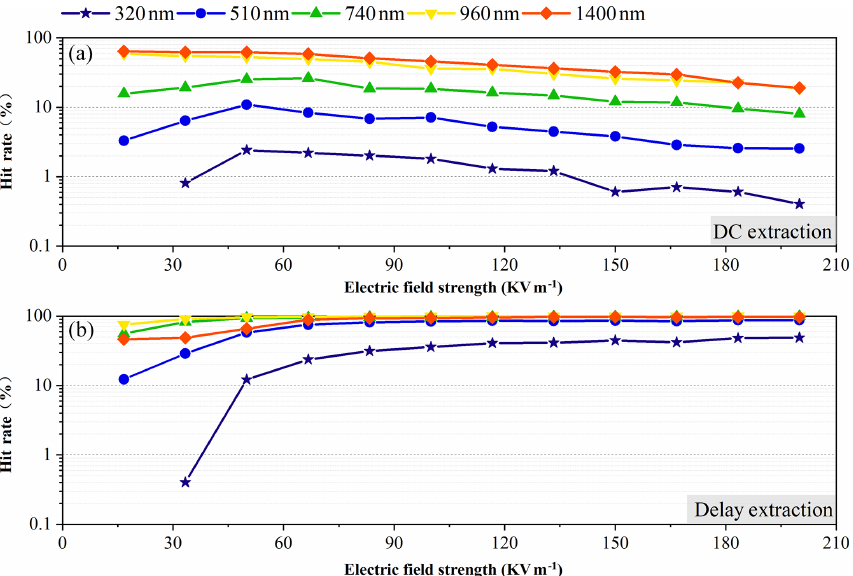
Figure 2. Comparison of hit rate dependencies for different sizes of PSL particles in two cases: (a) constant electric field (DC extraction) and (b) pulsed electric field (delayed extraction;